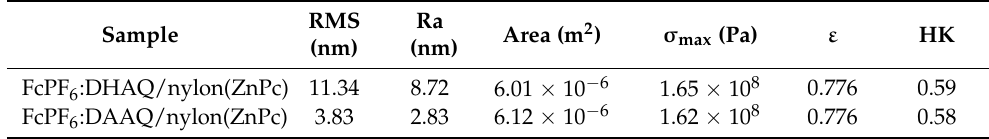
Figure 3. The AFM images for ( a ) FcPF 6 :DHAQ/nylon(ZnPc) and ( b ) FcPF 6 :DAAQ/nylon(ZnPc). Table 2. Roughness and mechanical parameters of the